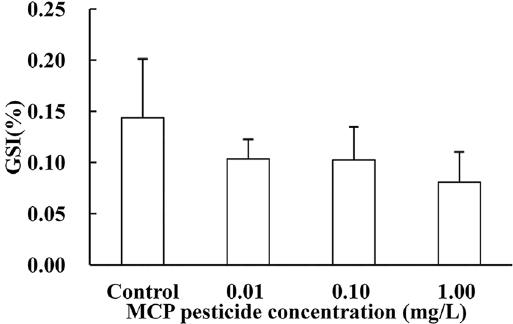
Figure 1. Effects of MCP pesticide on GSI of male goldfish ( Carassius auratus ).